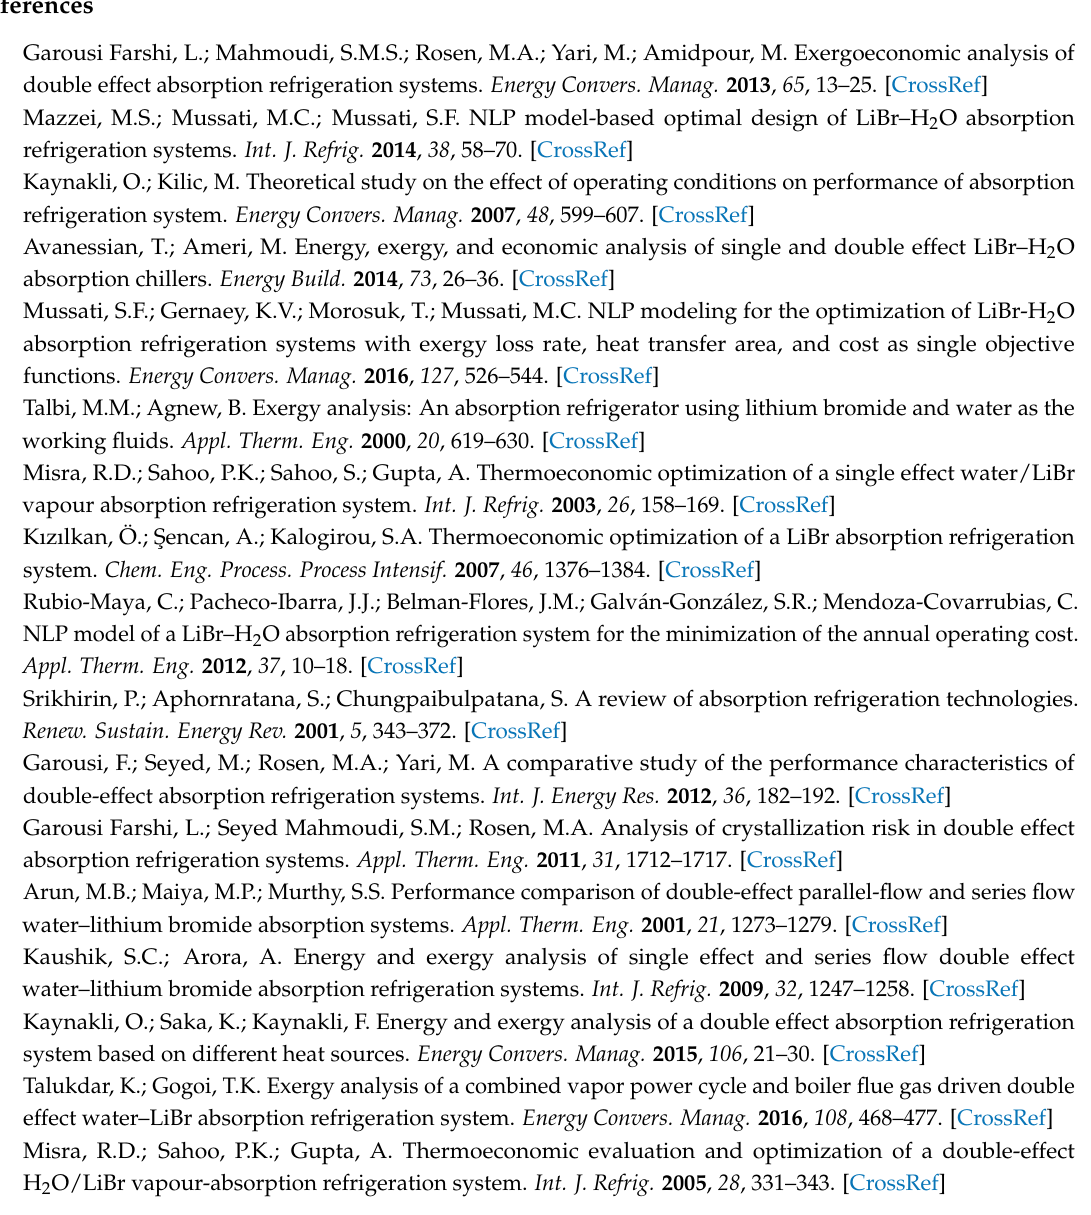
Figure S1: Schematic of the studied double-effect H 2 O-LiBr ARS; Table S1: Parameter values for estimating process unit investment Z k